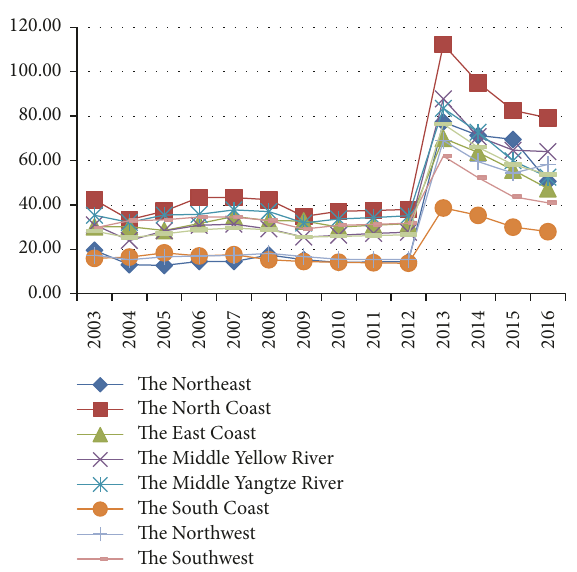
Figure 1: Time change trend of PM 2.5 in